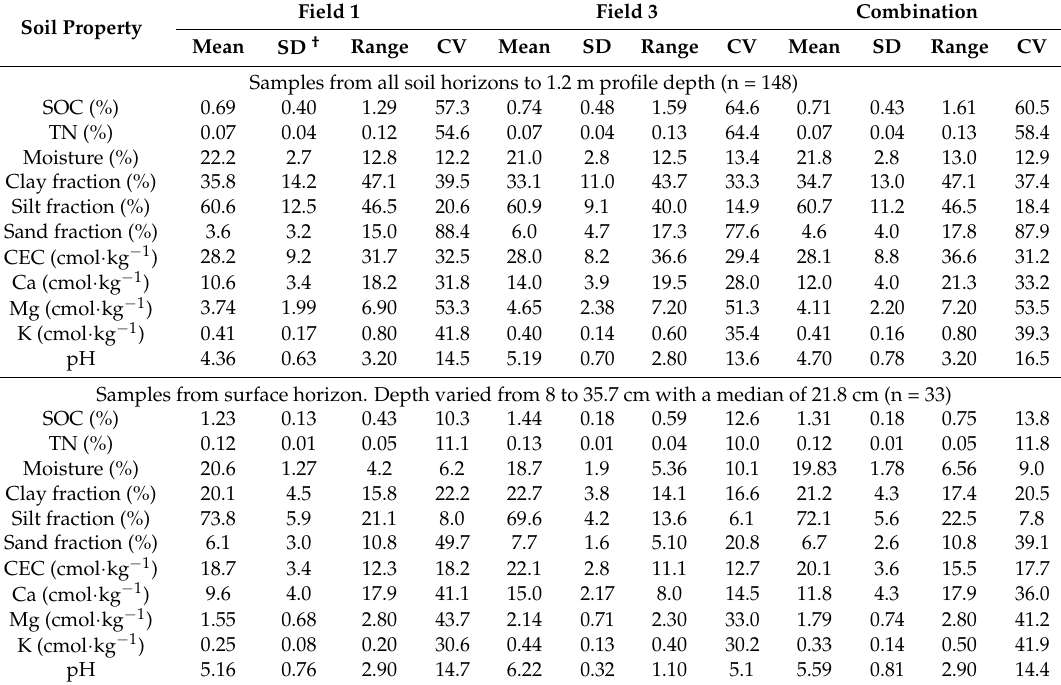
Table 1. Summary statistics of lab-determined soil properties. Coefficient of variation (CV) is in %. Soil